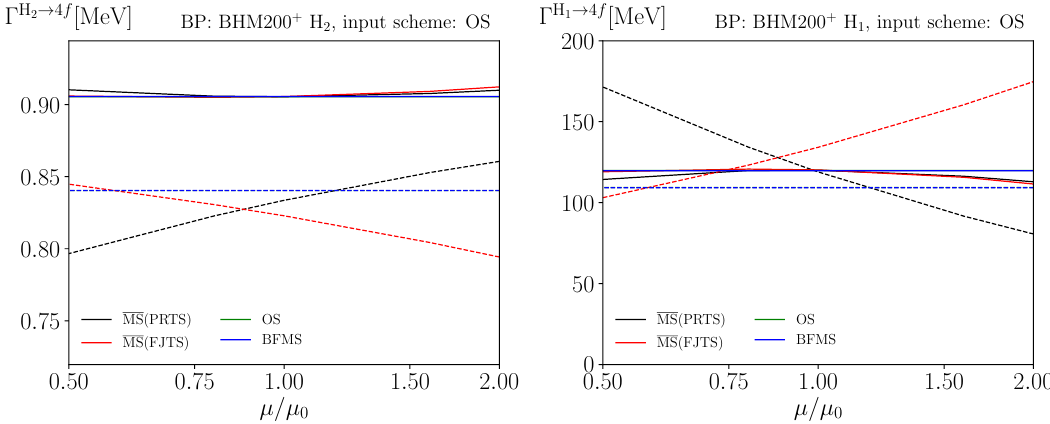
Figure 1 . Scale dependence of the decay widths (cid:0) H 2 ! 4 f (left) and (cid:0) H 1 ! 4 f (right) of the light and heavy HSESM Higgs bosons H 2 and H 1 for the HSESM scenario BHM200 + in di(cid:11)erent renormal- ization schemes, with the OS scheme as input scheme (and full conversion of the input parameters into the other schemes). LO results are shown as dashed, NLO as full lines; the central scale is set to (cid:22) 0 = M H . 2